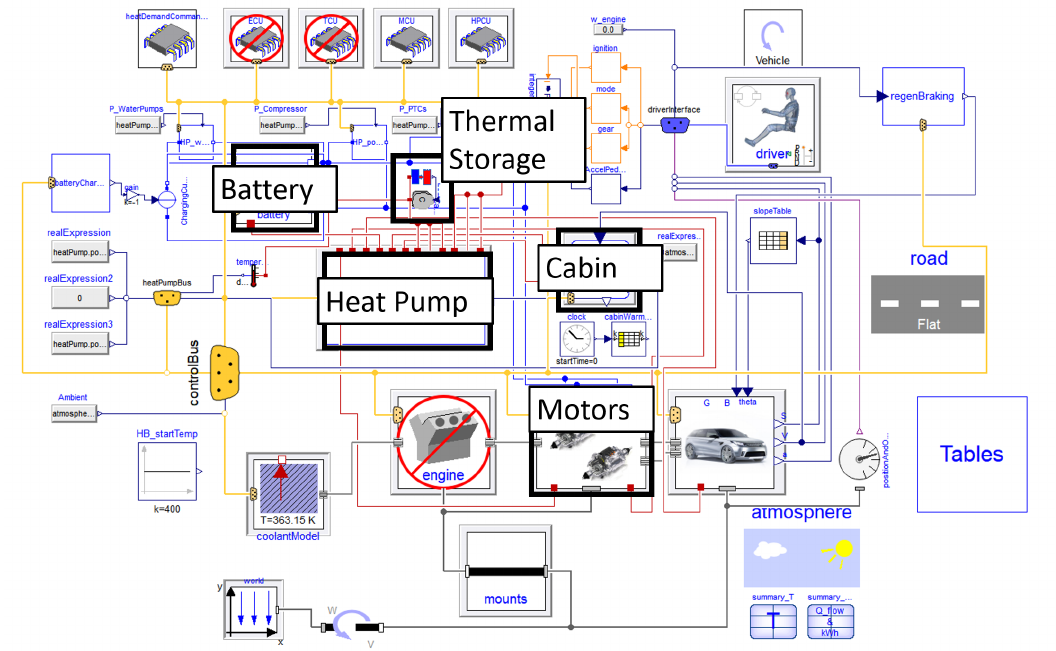
( a ) A view of the model produced in Dymola with key blocks highlighted, relating to those components identified in Figure 1.